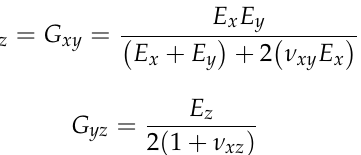
identical along the fiber’s direction in the textile’s plane and different in the out-of-plane direction. Since two different elements were used to simulate the mortar and the textile, along the two directions in the plane of the textile. Two local coordinate systems were specified in the modelling for each side of the wall following the right-hand rule in which the local x- and y -axes were parallel to the textile plane, while the z -axis was perpendicular. The required parameters for the carbon textile modelling were the moduli of longi- tudinal elasticity ( E x , E y , and E z ), moduli of transversal elasticity ( G xy , G yz , and G xz ) and Poisson’s ratios ( ν xy , ν yz , and ν xz ). Based on the values used in the experiment of the carbon textile, the moduli of longitudinal elasticity were 240, 30, and 30 GPa in x , y , and z directions, respectively. The Poisson’s ratios were assumed equal to 0.22, 0.22, and 0.3 for ν xy , ν xz , and ν yz , respectively [33]. The moduli of transversal elasticity, G xy , G xz , and G yz